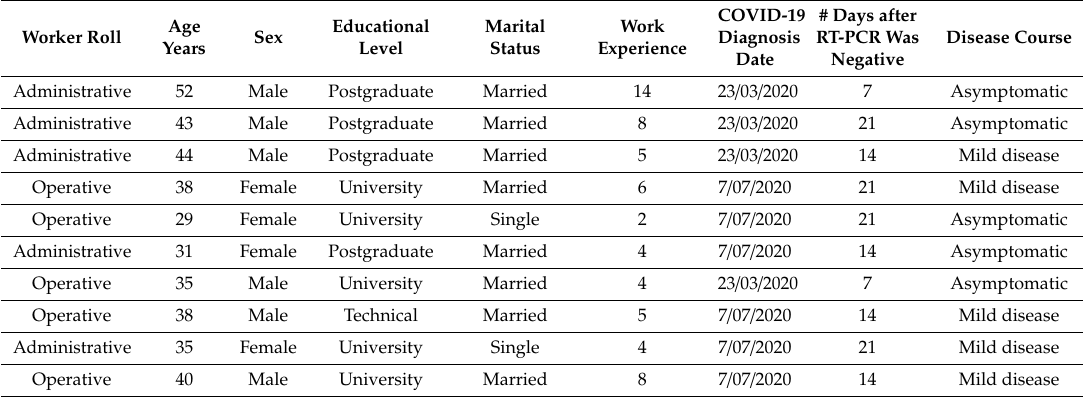
Table 4. Sociodemographic characteristics of the interview